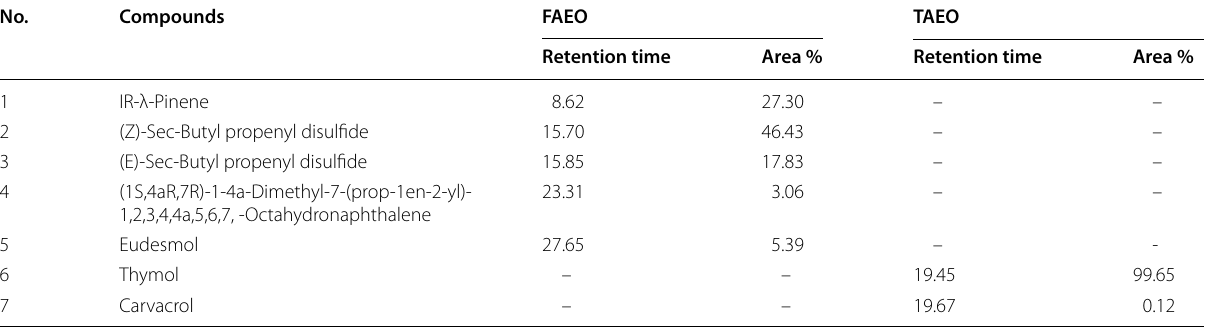
Table 2 The identified compounds of Ferula assafoetida essential oil (FAEO) and Trachyspermum ammi essential oil (TAEO) by GC–MS